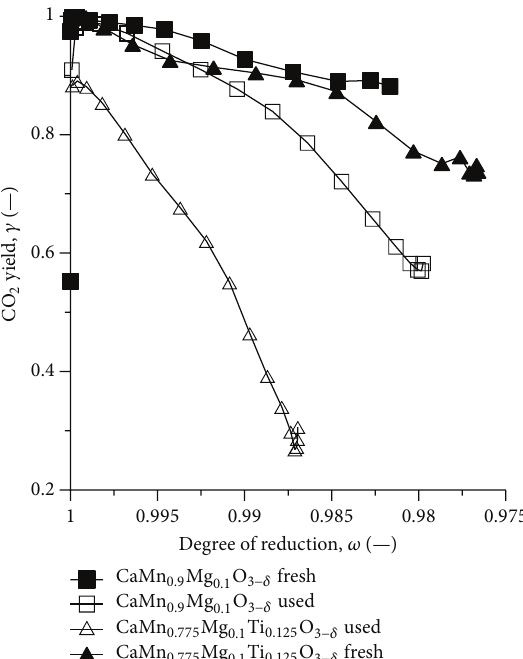
Figure 7: Particle size distribution for CaMn 0.775 Mg 0.1 Ti 0.125 O 3−𝛿 , comparison between fresh particles added to reactor and the retrieved used ones.